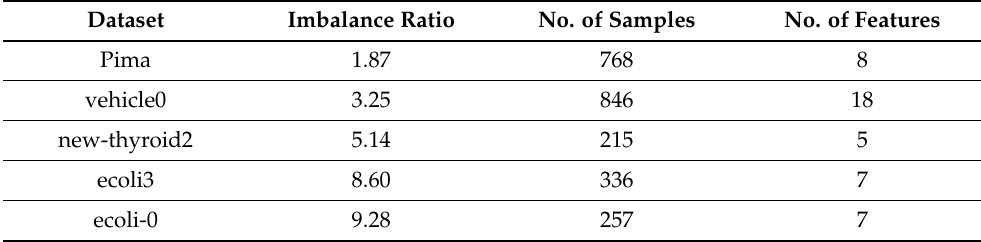
Table 2. Benchmark datasets: the KEEL imbalanced datasets.